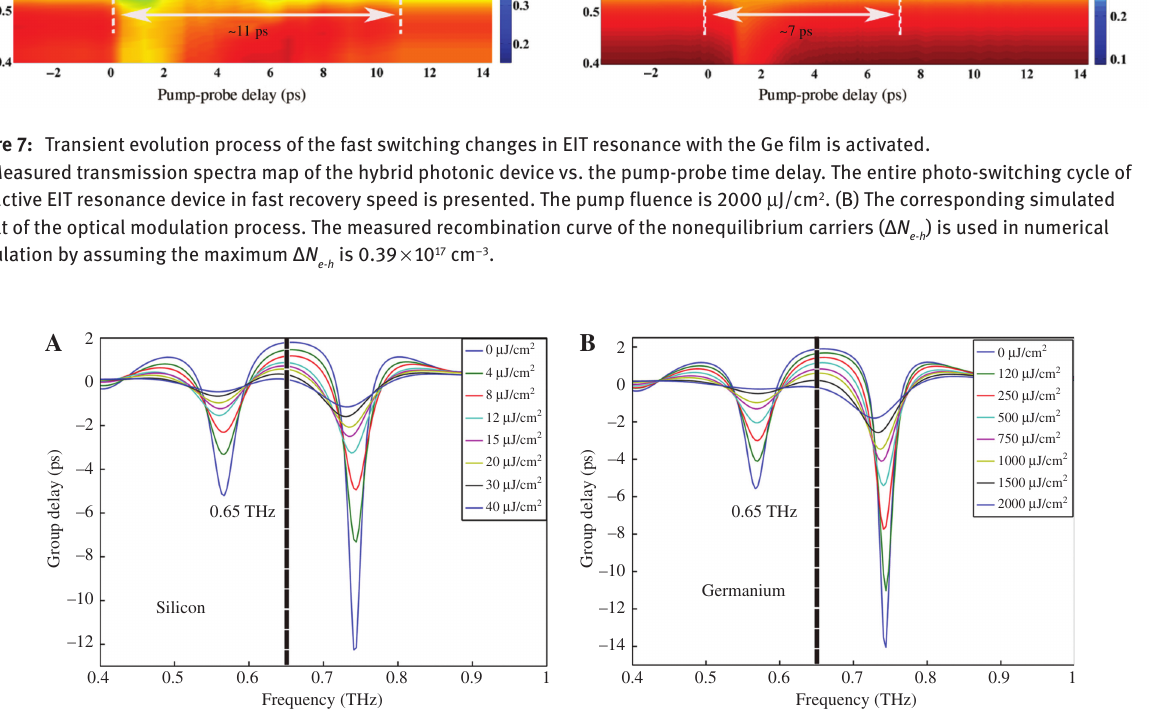
Figure 8: Optically tunable active group delay data extracted from experiment results as a function of pump fluence. (A) The pump pulses are back-propagated and the Si film is photon doped. (B) The pump pulses are travel forward and the Ge film is